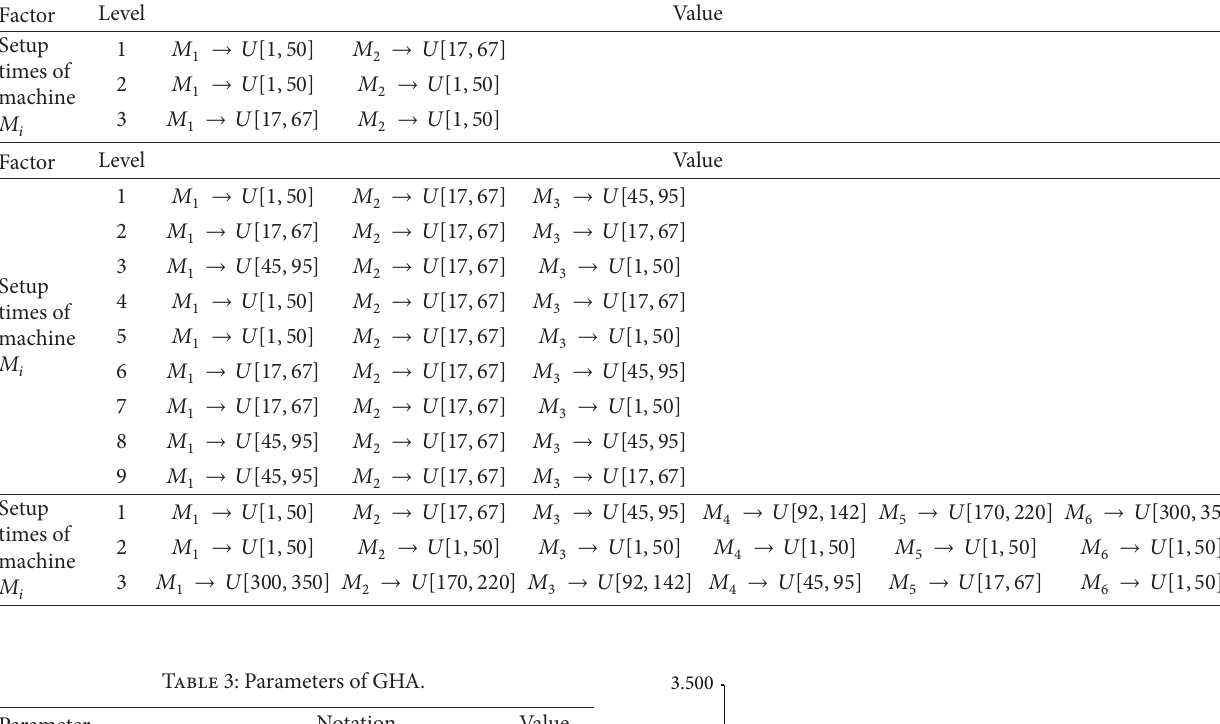
Table 2: Benchmark of instances for the FDSGSLE problem.